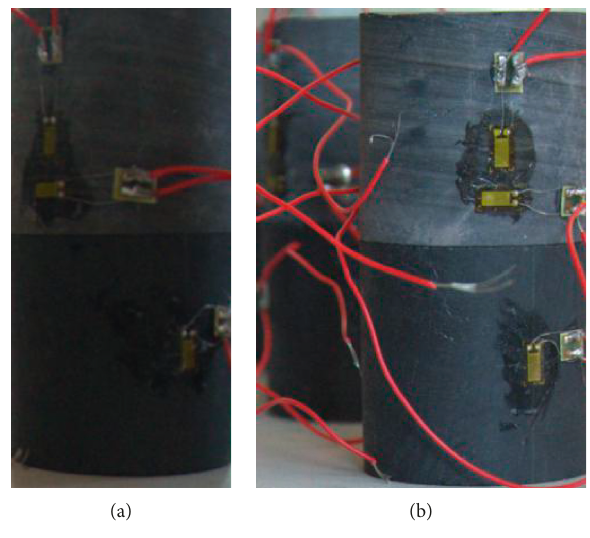
Figure 3: Samples before